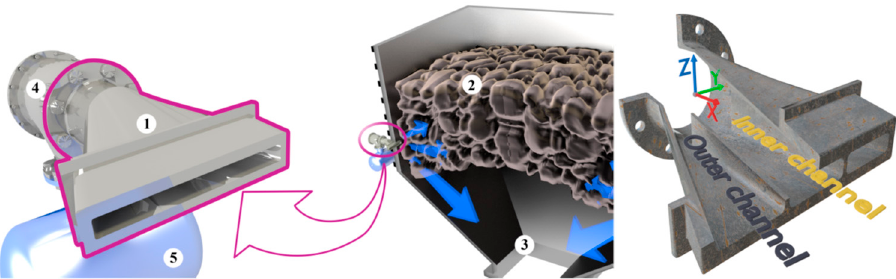
Figure 3. Visualization of the pneumatic pulsator system: inner and outer channel, including (1) nozzle, (2) loose material, (3) silo, (4) head, and (5) pressure accumulator. (1) nozzle, (2) loose material, (3) silo, (4) head, and (5) pressure